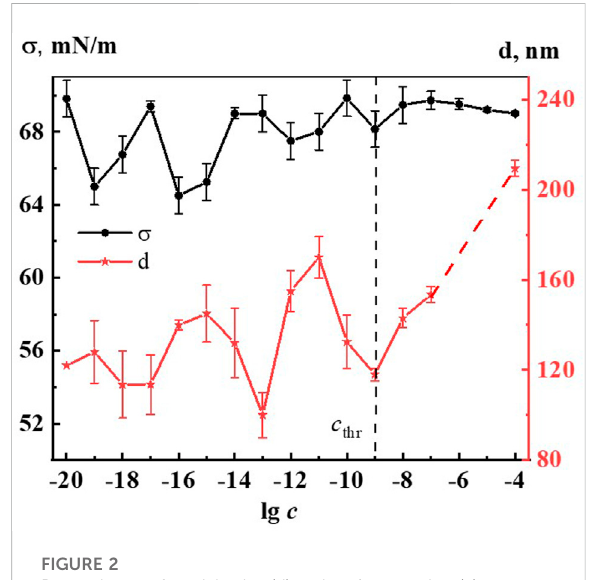
FIGURE 2 Dependence of particle size (d) and surface tension ( σ ) on concentration (c, M) of the Dox systems. Measurements were performed at 25 ± 0.1 ° C. The dotted line indicates the threshold concentration ( c thr